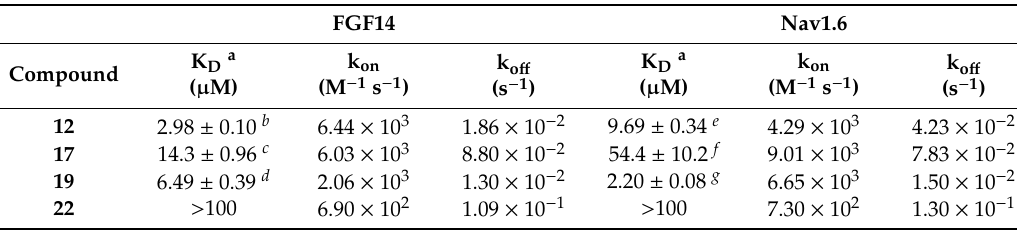
Table 3. Biophysical characterization of peptidomimetic binding to FGF14 and Nav1.6 by Surface Plasmon Resonance (SPR).